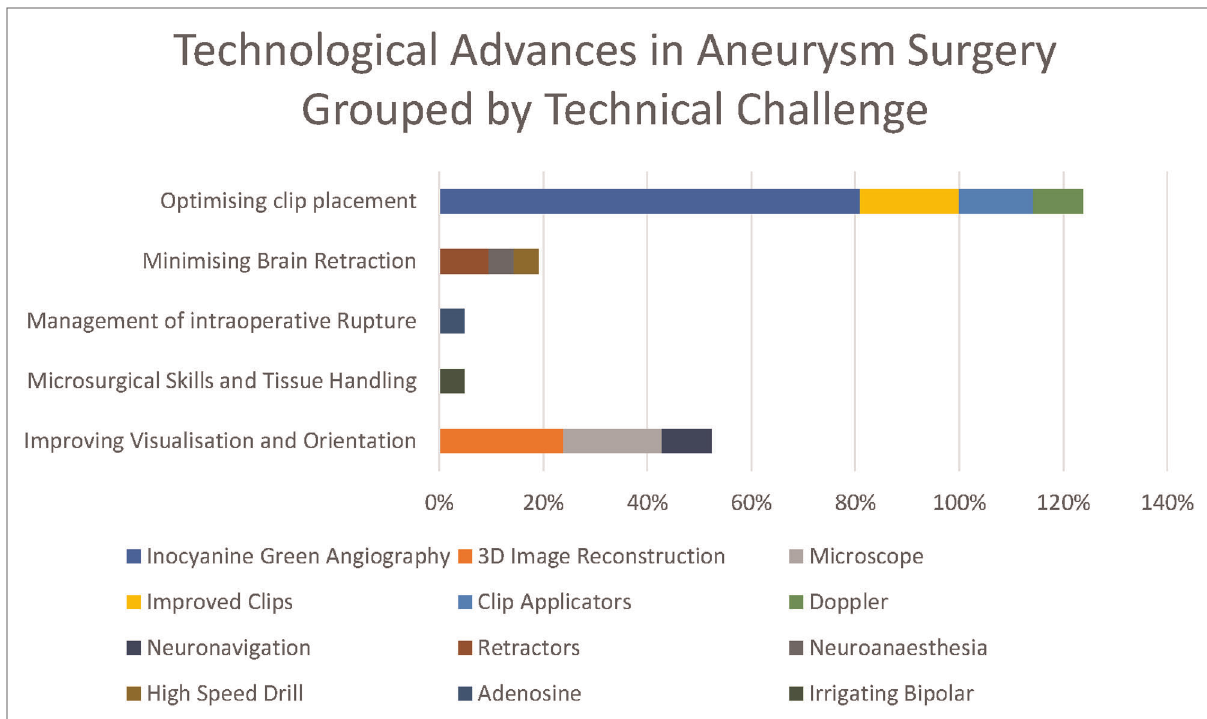
FIGURE 5 Technological advances grouped by technical challenge they respond to (as percentages express the percentage of respondents citing each technological advance, these percentages do not sum to